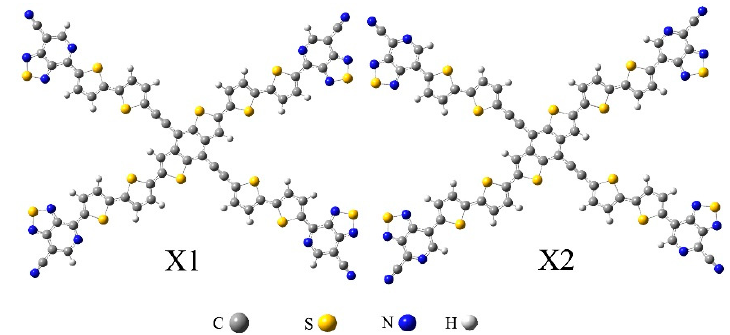
Figure 1. The structures of donors X1 and X2 from Ref. [32].